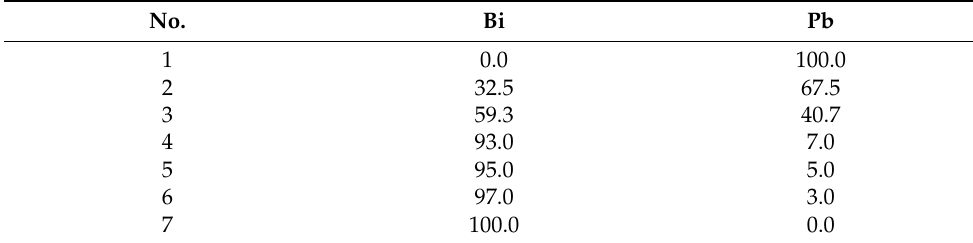
Table 1. Working electrodes’ compositions